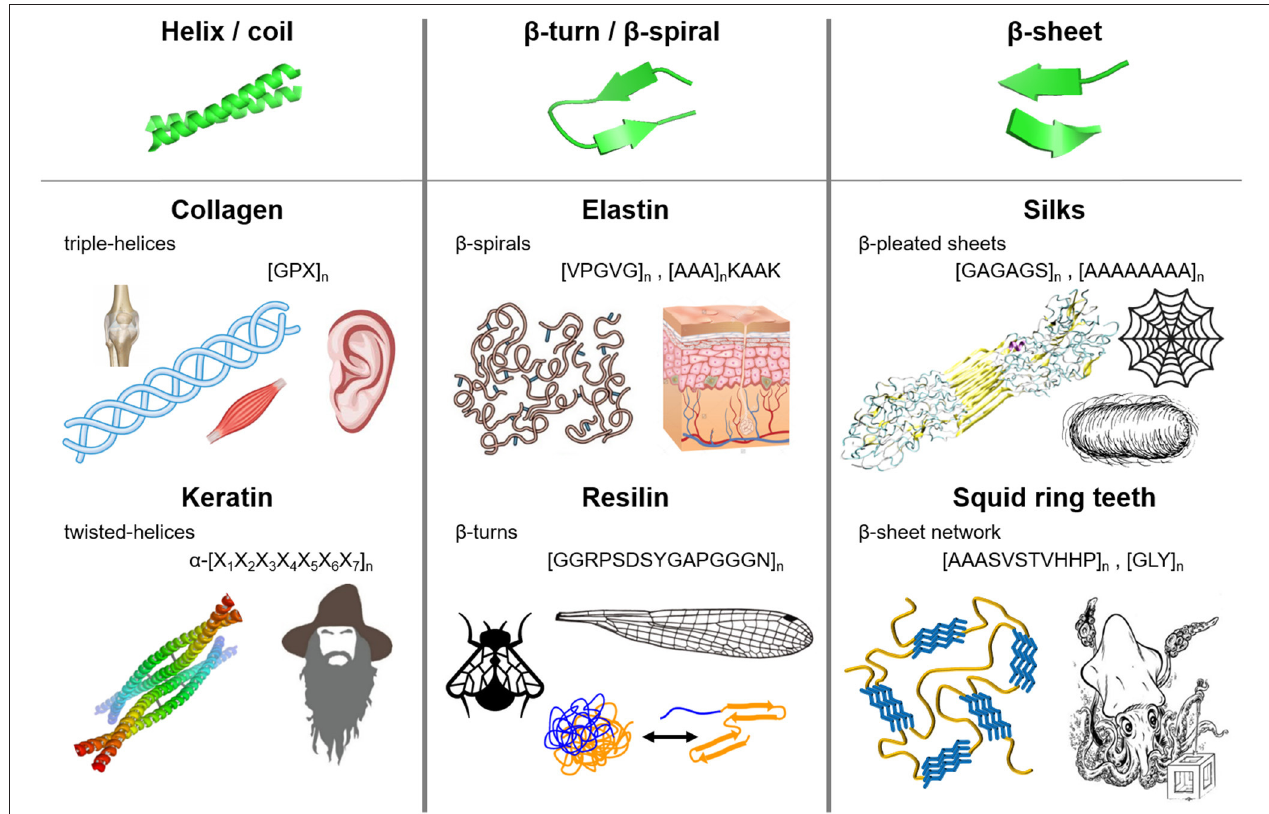
FIGURE 1 | Molecular architecture and repetitive sequences of fibrous protein polymers: (i) coiled-coils (e.g., collagen and keratin), (ii) β -turns/spirals (e.g. elastin and resilin), and (iii) β -sheets (e.g., silks and squid ring